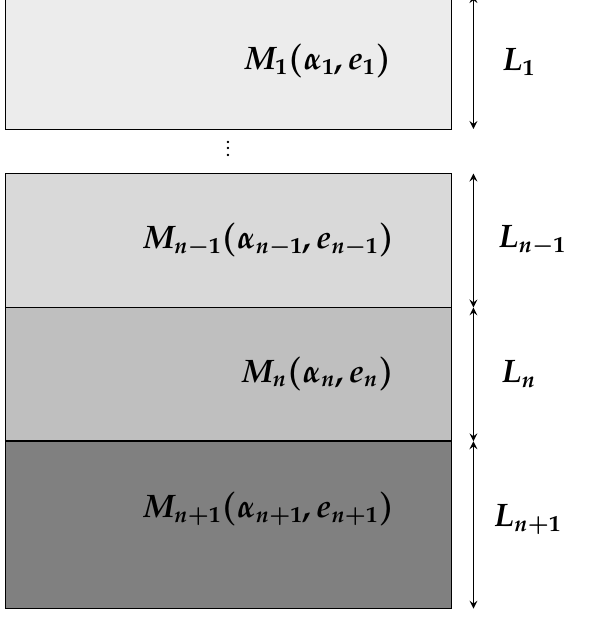
Figure 1. System of n coating layer materials M 1 ,..., M n on a substrate material M n + 1